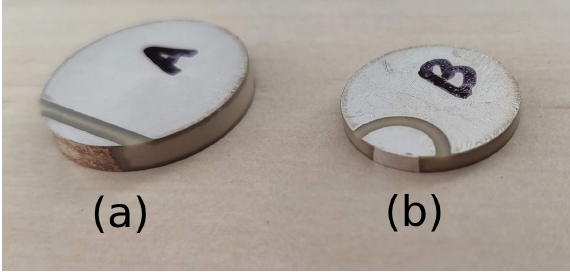
Figure 1. Piezoelectric transducers with wrap-around electrodes. Wrapping of the electrode from the bottom to the top surface is apparent, ( a ) wrapping in the shape of a circular segment; ( b ) wrapping in the shape of an intersection of circles.